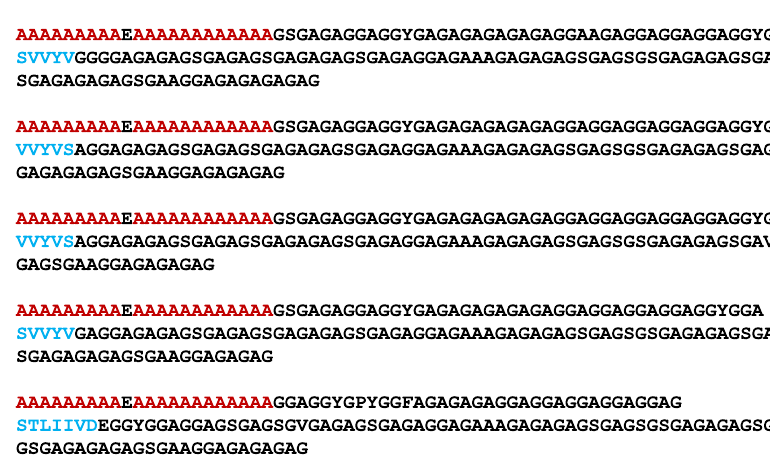
Fig. 2 Tandem repeat motifs in the bagworm H-Fib. Five tandem repeat motifs, each of which is composed of a PAB and NPAB sequence, were identi fi ed by silk gland transcriptomic analysis. The red characters indicate the polyalanine sequence and the blue characters show non-repeating residues, which are unique to each unit